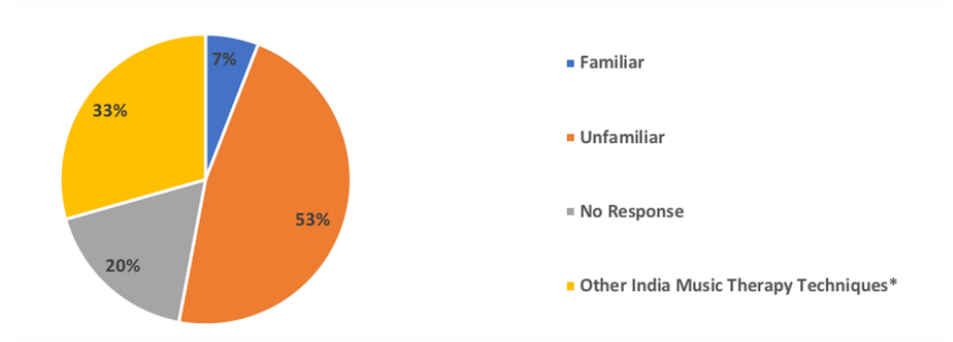
Music Therapists Familiar with KIMMA